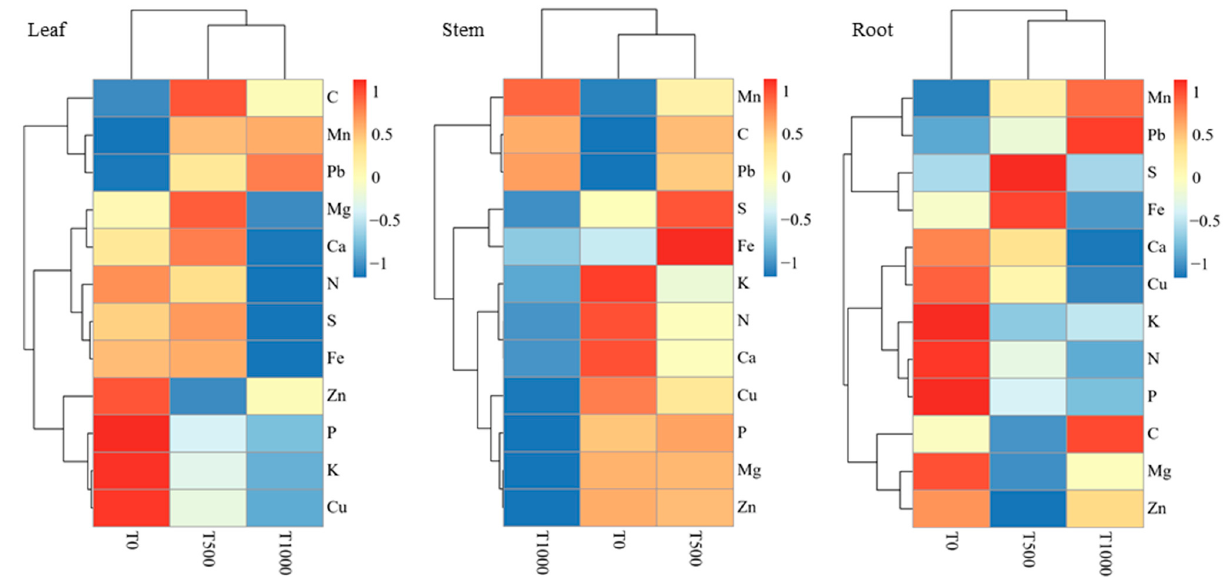
Figure 3. Clustered heatmap of averaged element concentrations (rows) in R. chinensis under different treatments (columns).